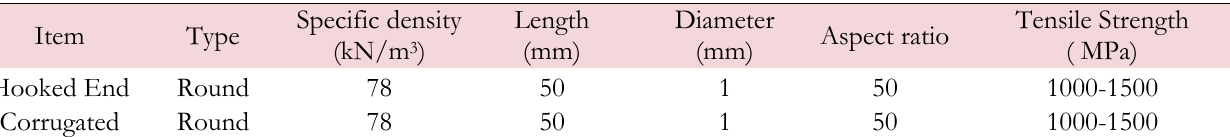
Table 2 : Physical properties of steel